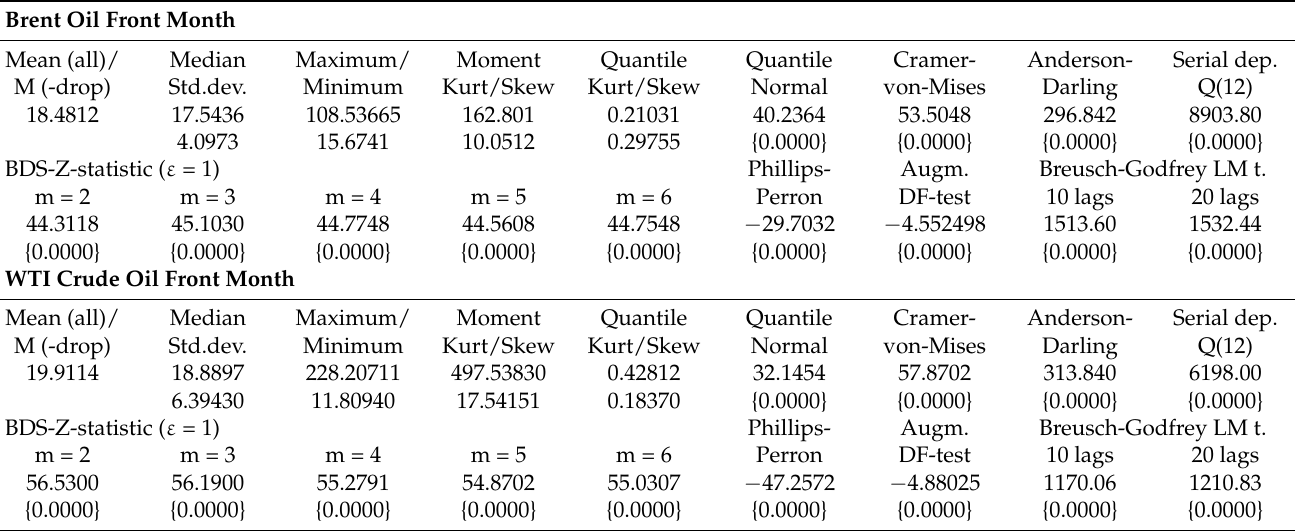
Table 3. Volatility Characteristics for the Oil Front Month